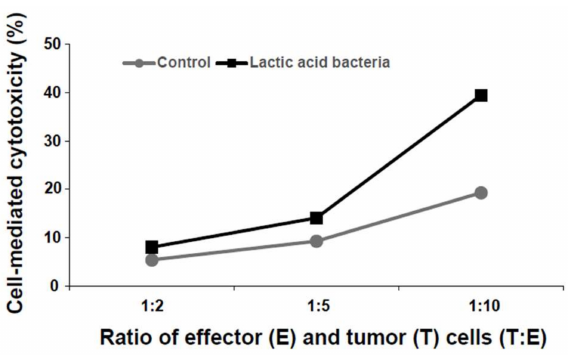
Figure 2. Cell-mediated cytotoxicity of natural killer (NK) cells by a six lactic acid bacteria mixture. KHYG-1 cells were treated with a six lactic acid bacteria mixture for 24 h at 37 ◦ C in a 5% CO 2 incubator. The treated cells were reacted with K562 cells for 4 h at 37 ◦ C in a 5% CO 2 incubator. Cell-mediated cytotoxicity increased for KHYG-1 cells that had been treated with the six lactic acid bacteria